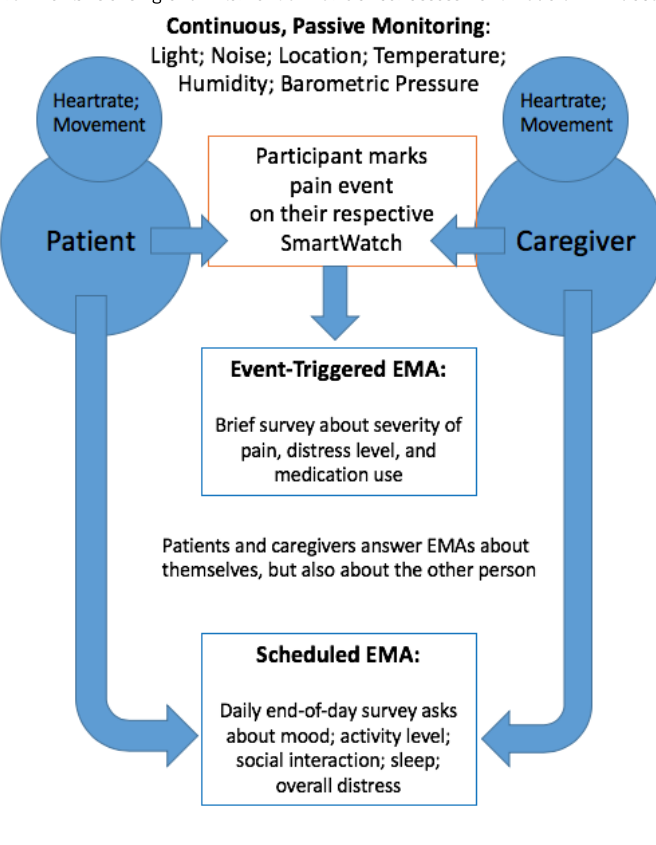
Figure 3. The Behavioral and Environmental Sensing and Intervention for Cancer assessment model. EMA: ecological momentary